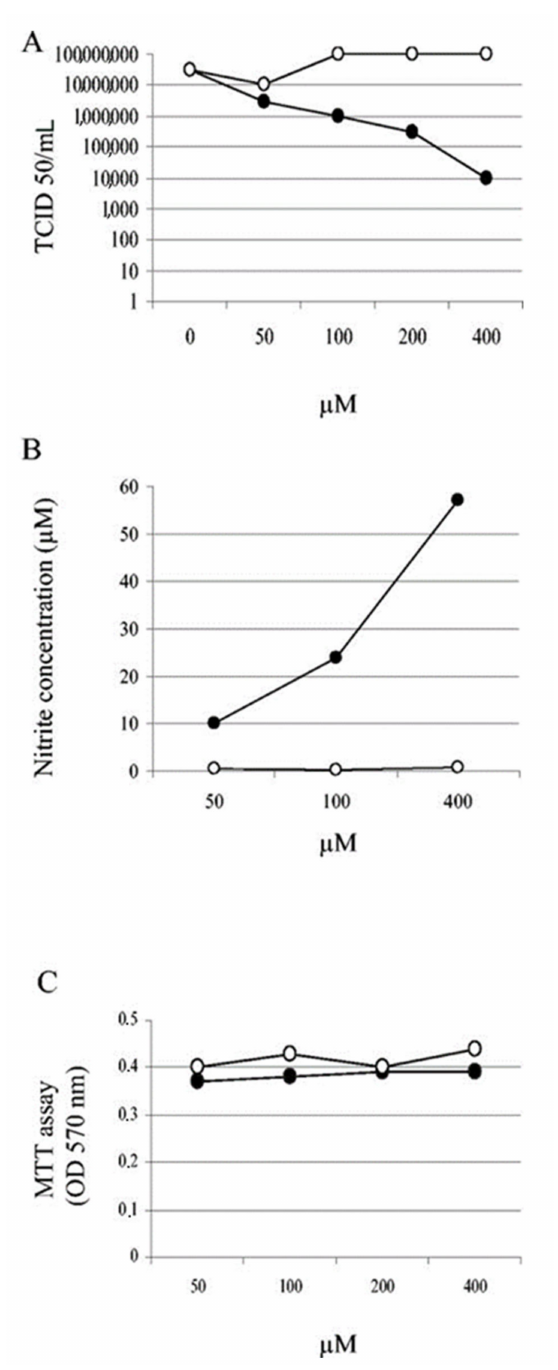
Figure 6. Cells were infected with SARS-CoV-1 at an MOI of 1.0. At 1 hpi, the cells were treated with different concentrations of SNAP ( • ) and NAP ( ). ( A ) Supernatants were harvested at 24 hpi (cid:35) and titers were determined. ( B ) Nitrite concentrations produced at 24 h posttreatment with different concentrations of SNAP and NAP. ( C ) Cell viability, as determined by MTT assays. The mean values from two experiments are indicated. Source: